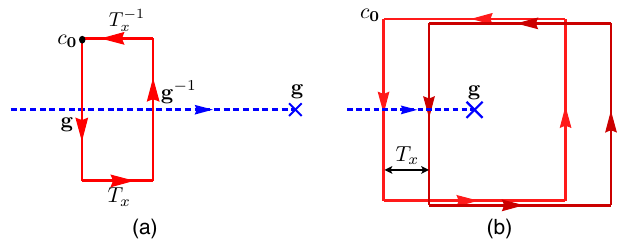
FIG. 5. (a) Braiding an anyon c around a unit length of 0 g -defect branch line is equivalent to the local action of R − 1 R R R − 1 on the anyon (shown here for i ¼ x ). This implies T i g g T i ; g Þ per that g -defect branch lines carry topological charge b ð T i ˆ i unit length in the direction. (b) The same result is obtained by comparing the results of braiding c around two loops, each of 0 which encloses the g defect, and where one is translated relative ˆ i to the other in the direction. This alternative derivation allows a generalization to the case where the g -defect branch line is not